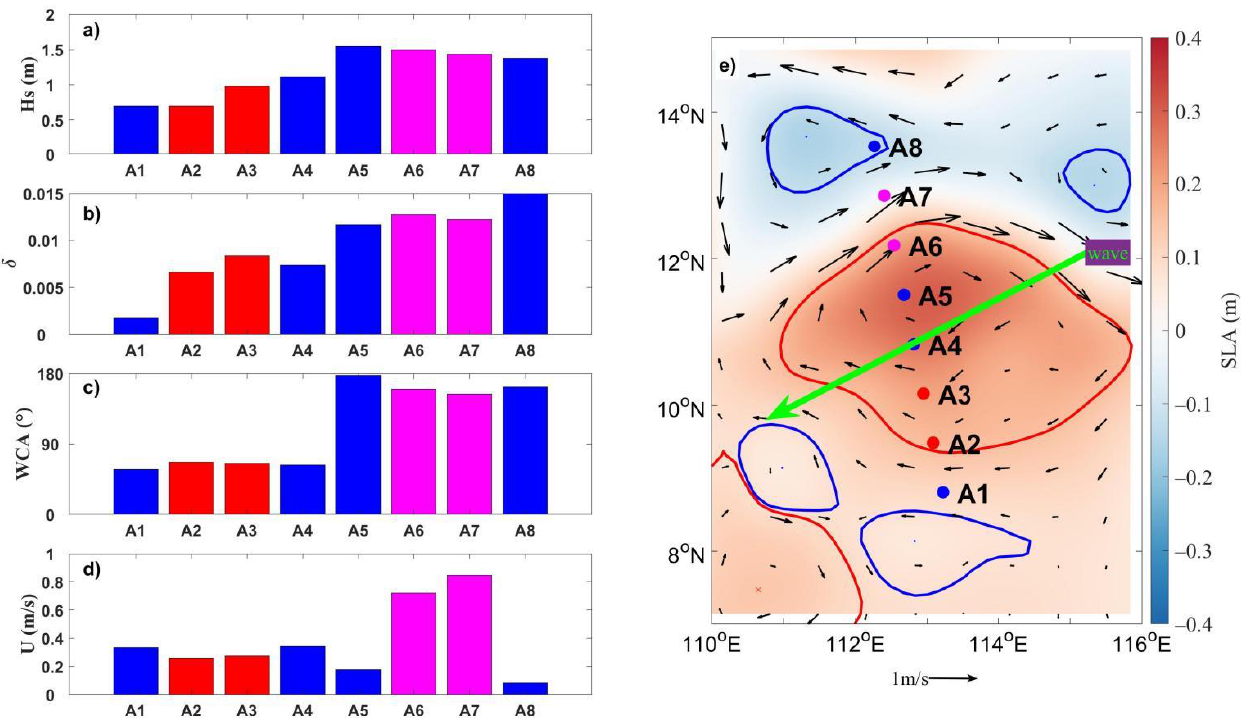
Figure 10. Variation of ( a ) H s , ( b ) δ , ( c ) WCA, and ( d ) U on the CFOSAT-SWIM wave track. Panel ( e ) is a zoomed black box of Figure 1. The dots in ( e ) represent the CFOSAT-SWIM wave track on 8 October 2019. The two red dots represent wave and currents propagating/flowing in the same direction. The two magenta dots represent the waves and currents propagating/flowing against one another. The green arrow represents the wave direction of ERA5 data in the area. The shading color, the black arrow, the red and blue lines are the same as in Figure 1.